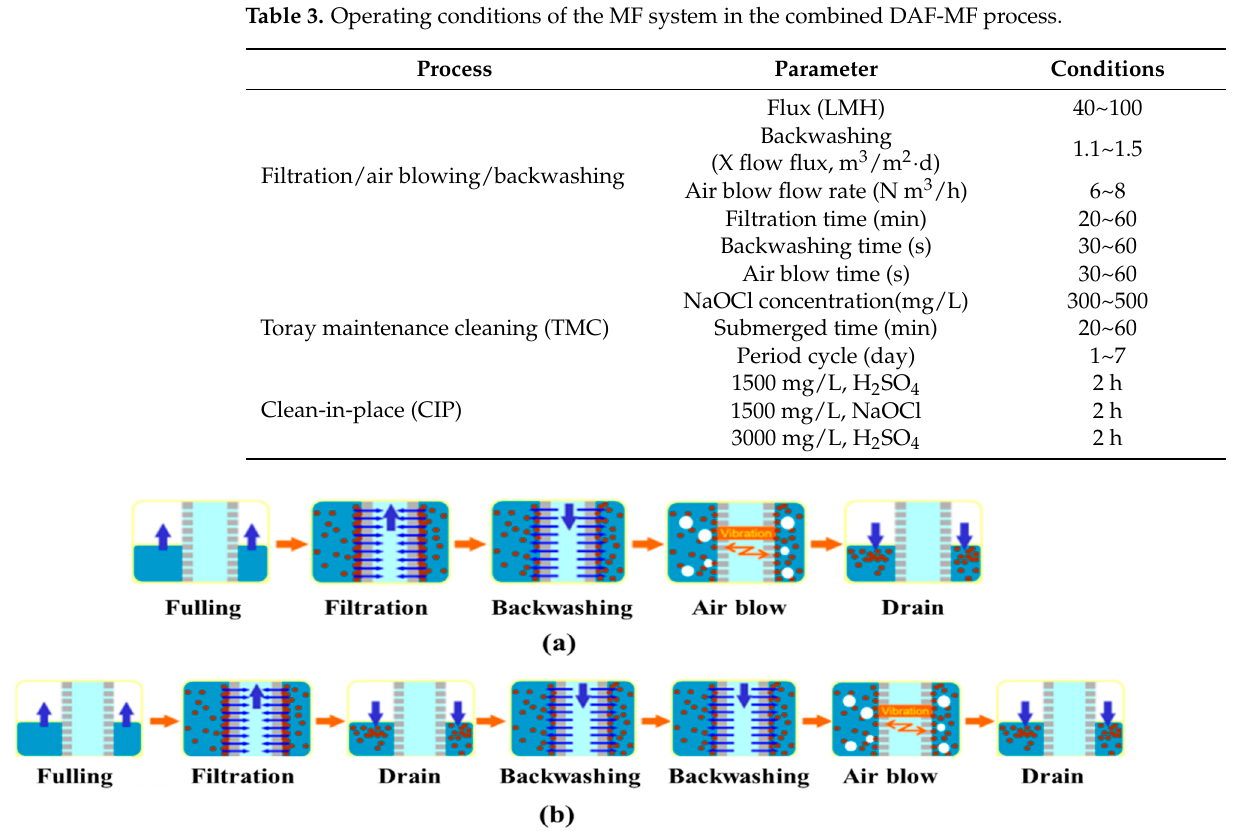
Figure 2. Sequence of ( a ) normal and ( b ) drain-backwash operations of the MF system .